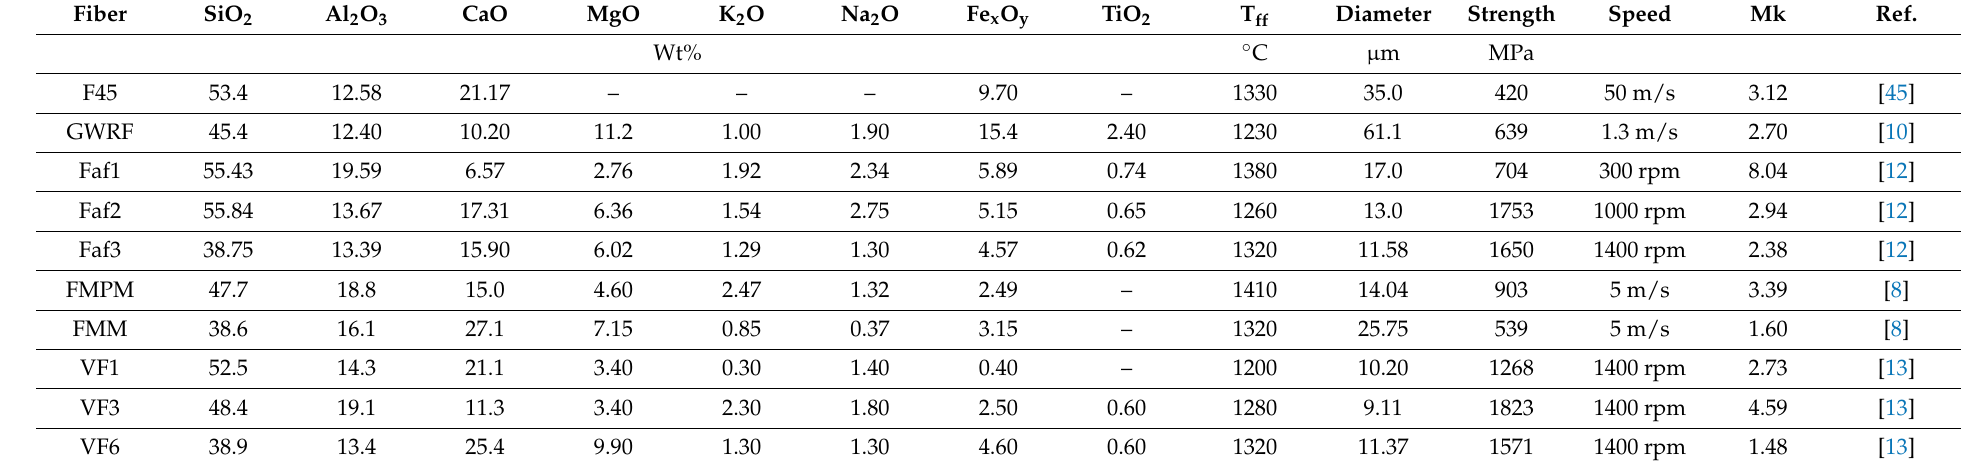
Table 2. Chemical composition, production method, diameter, tensile strength of the continuous fibers from solid